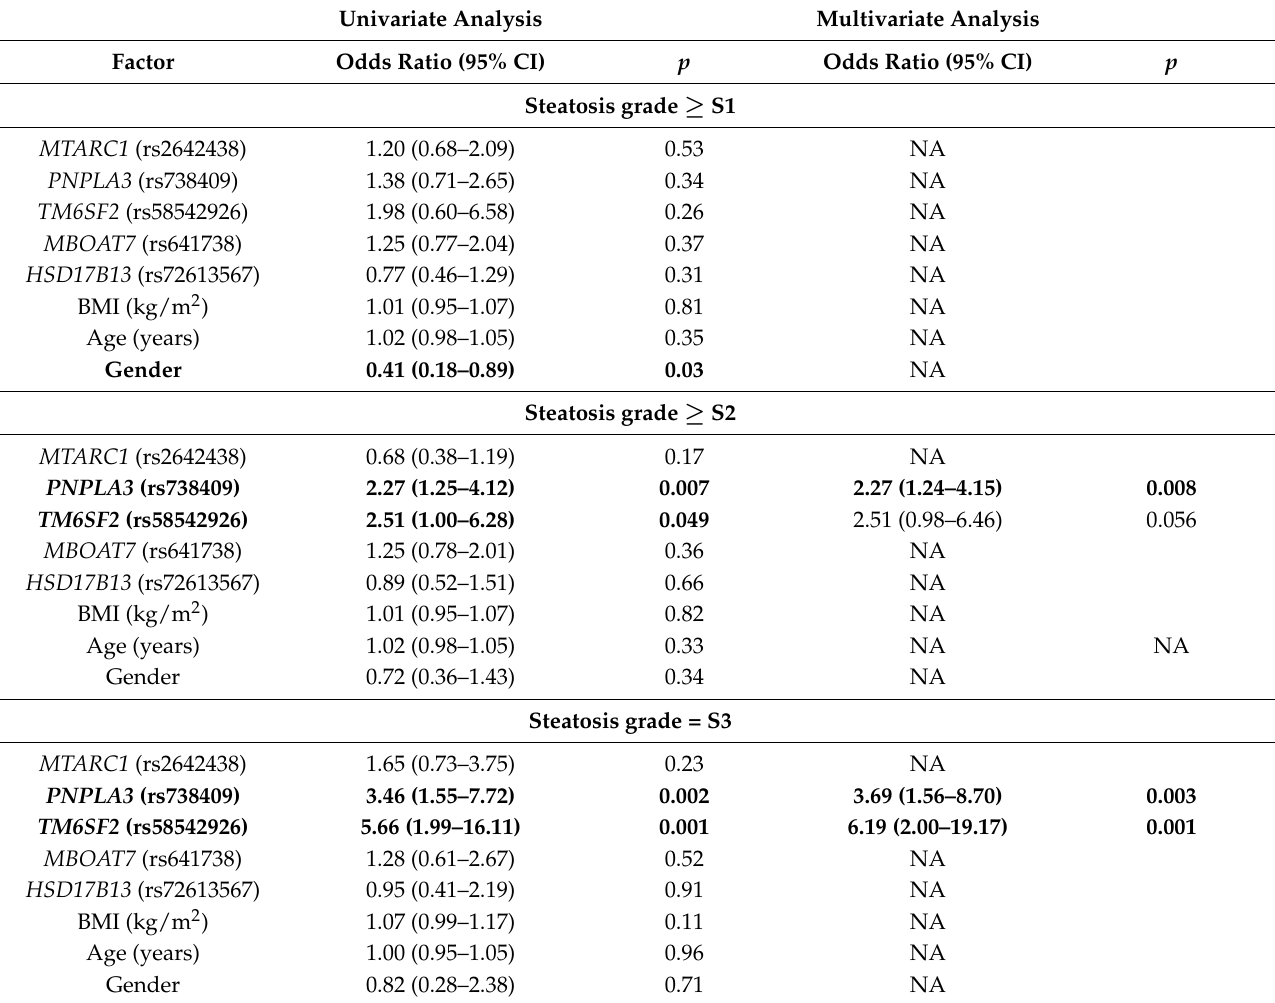
Table 5. Risk and protective factors for developing liver steatosis. Univariate Analysis Multivariate